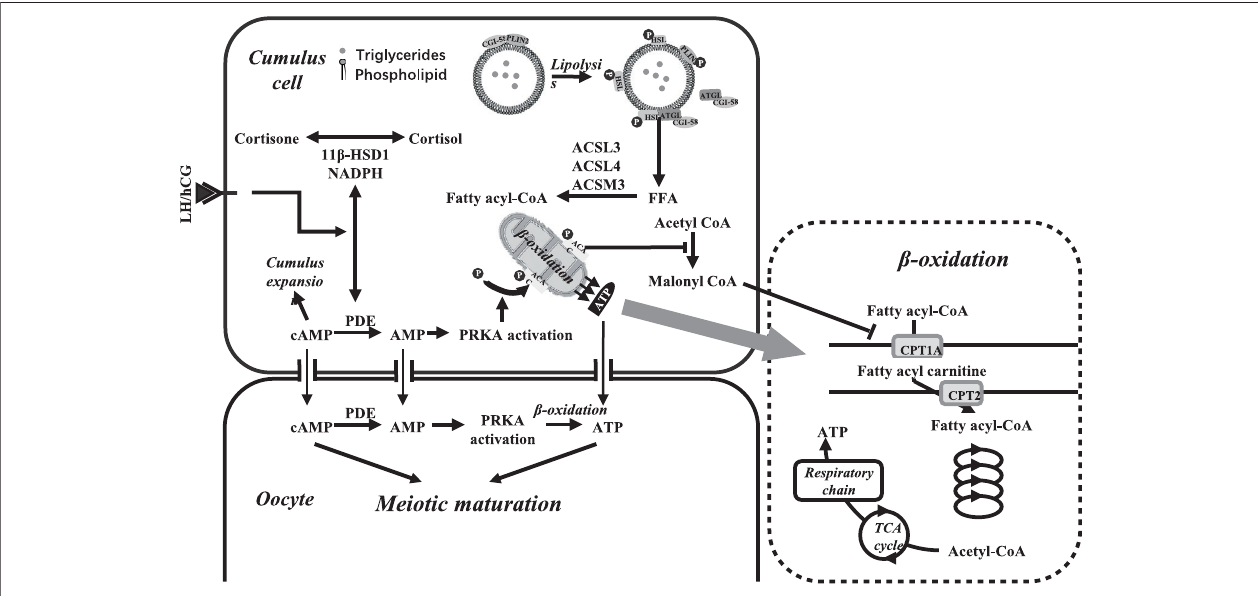
FIGURE 1 | Triglyceride breakdown and fatty acid oxidation in oocyte and cumulus cells. Triglyceride breakdown: In the presence of hormones or fatty acids, phosphorylated PLIN loses the protection on triglycerides and the binding capacity on CGI-58, thus activating HSL and ATGL and promoting lipolysis. Fatty acid oxidation:InthepresenceofLHorhCG,11 β -HSD1inthecumuluscellsofpreovulatoryfolliclescatalyzescorticosteroneintoactivecortisol.ActivatedPDEpromotesthe decomposition of cAMP, thereby promoting cumulus expansion. PRKA is activated by the AMP phosphorylate and inactive ACAC, which then downregulate the conversion of acetyl CoA to malonyl CoA and promote β -oxidation. cAMP and AMP can also be transported into oocytes via gap-junction, thus promoting meiotic maturation together with the ATP from cumulus cells and β -oxidation in oocytes. The pathway in the dotted line box showed the process of β -oxidation.